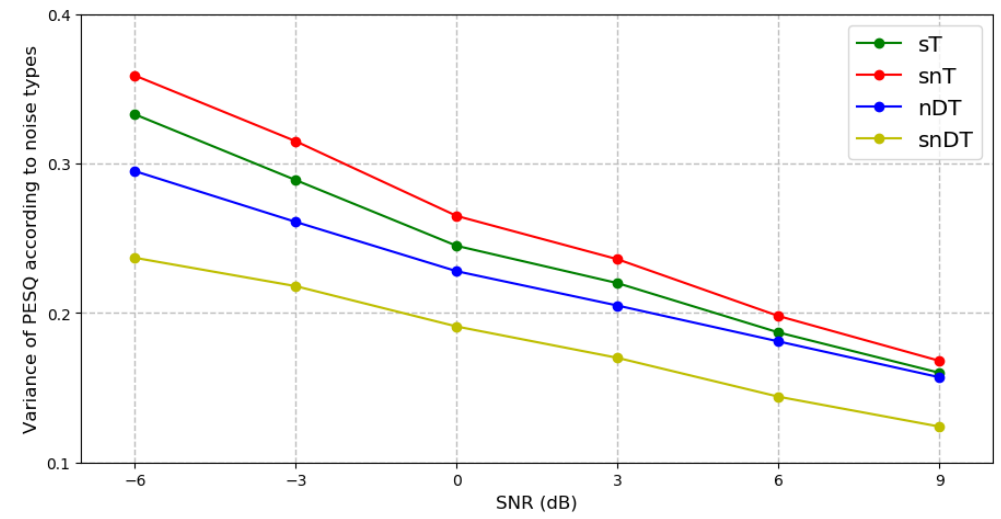
Figure 6. Variances of perceptual evaluation of speech quality (PESQ) scores for the 14 different noise types in various SNR